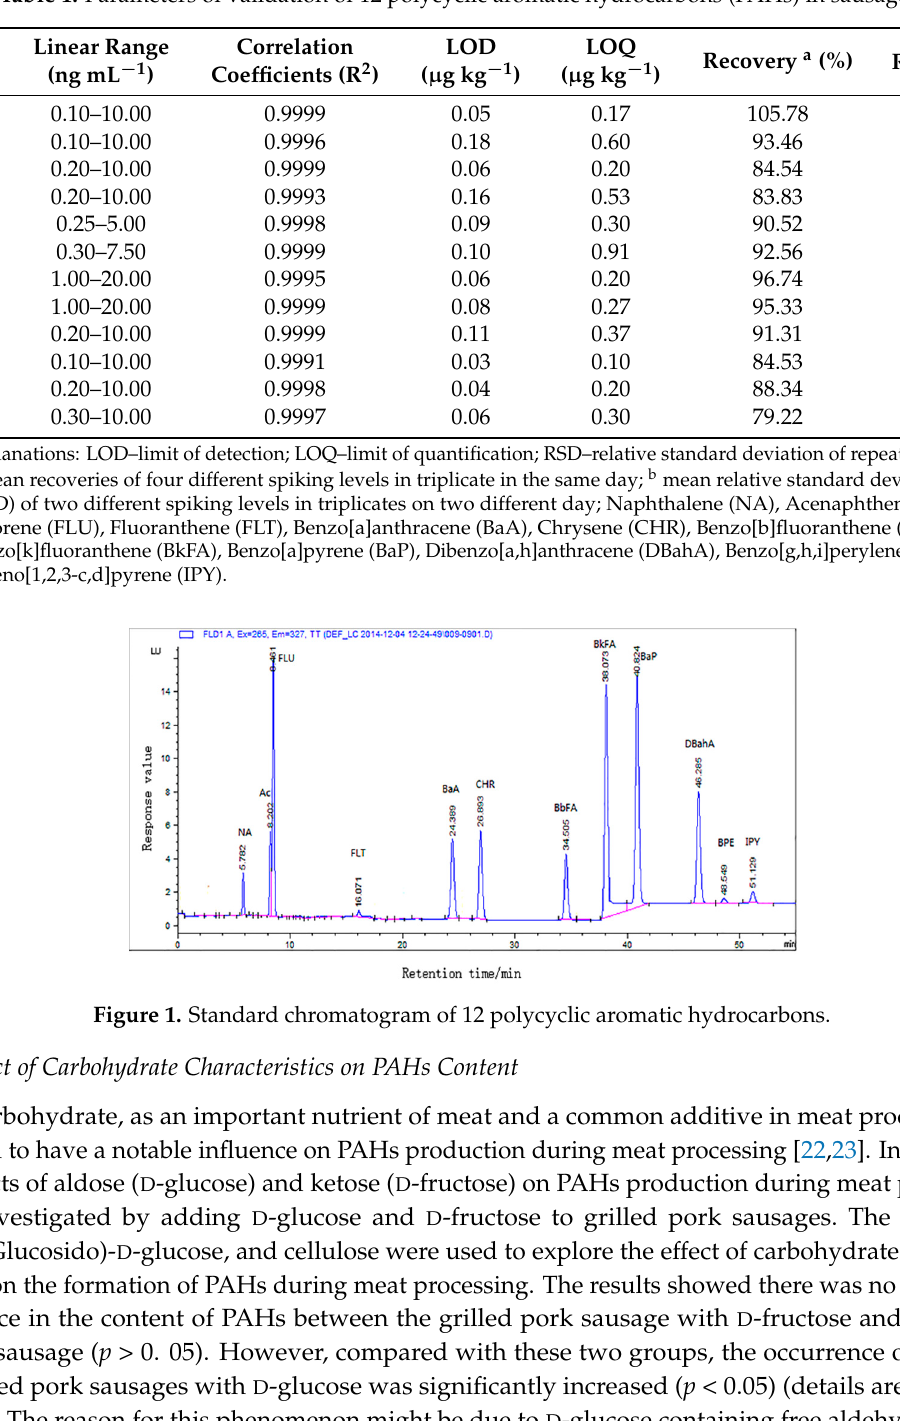
Table 1. Parameters of validation of 12 polycyclic aromatic hydrocarbons (PAHs) in sausages.